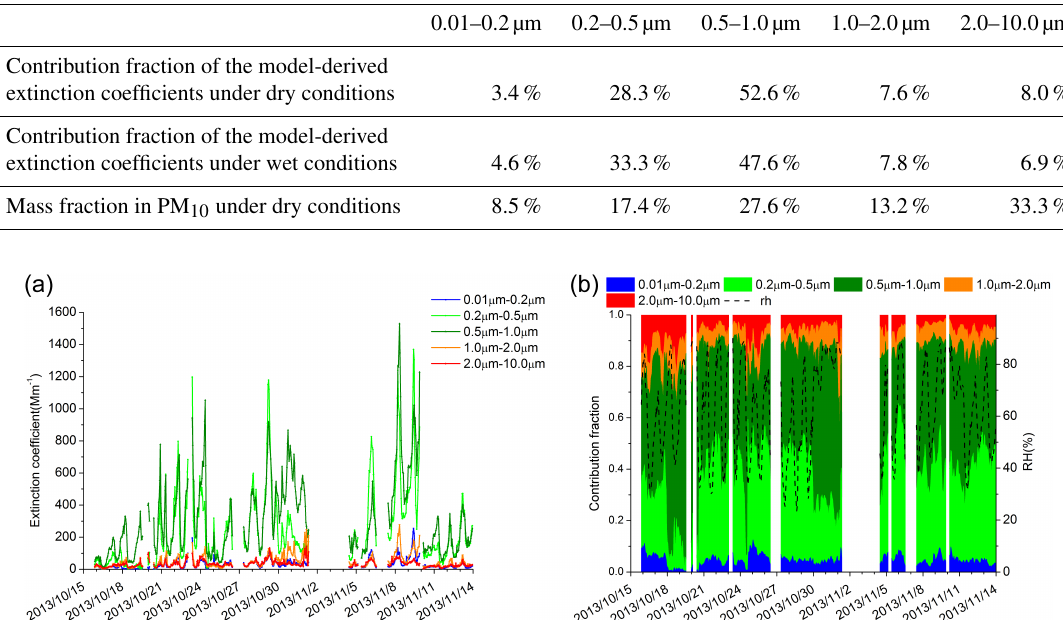
Table 3. Contribution fraction of the model-derived extinction coefficients under dry/wet conditions and mass fraction in PM 10 under dry conditions.